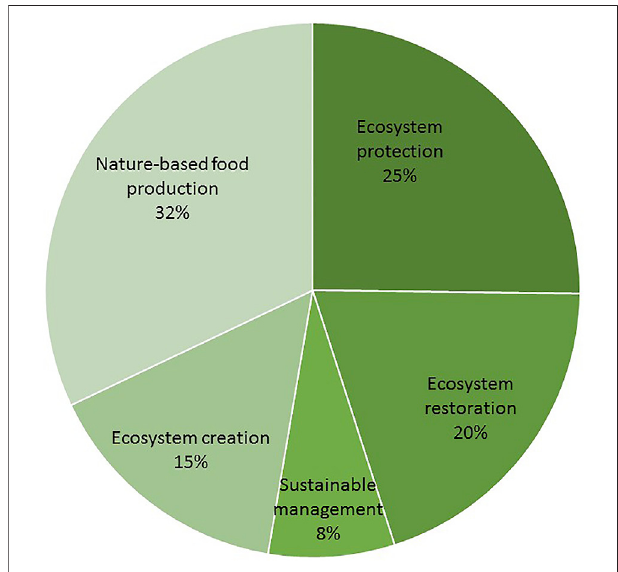
FIGURE 1 | Type of NbS intervention included in the studies that were